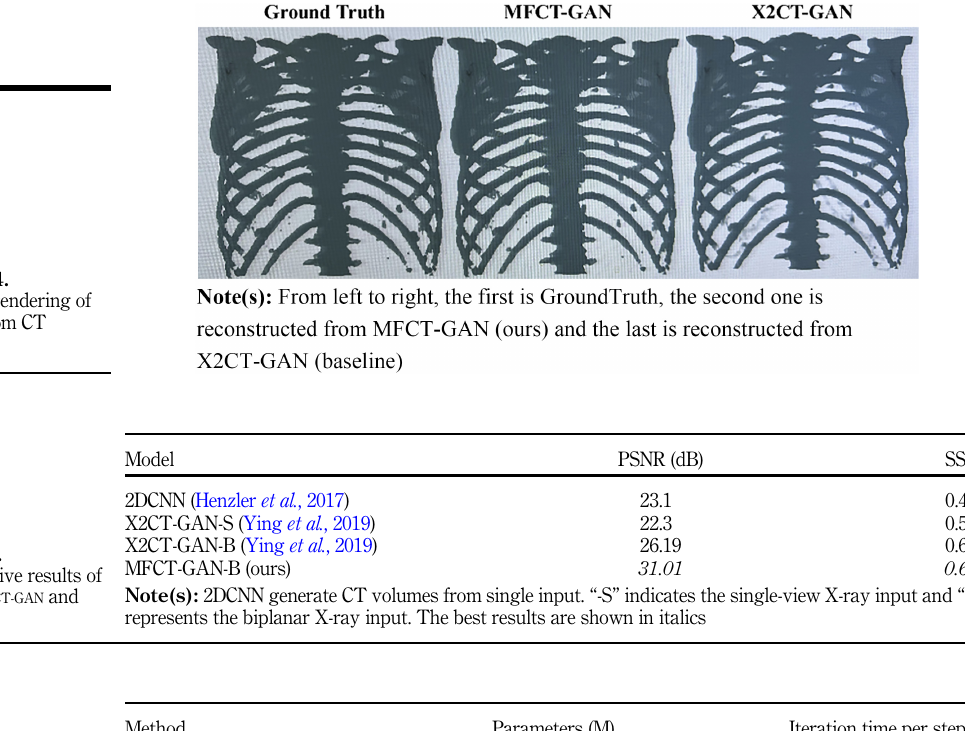
Table 2. C omparison of computational performance results of different feature extraction networks